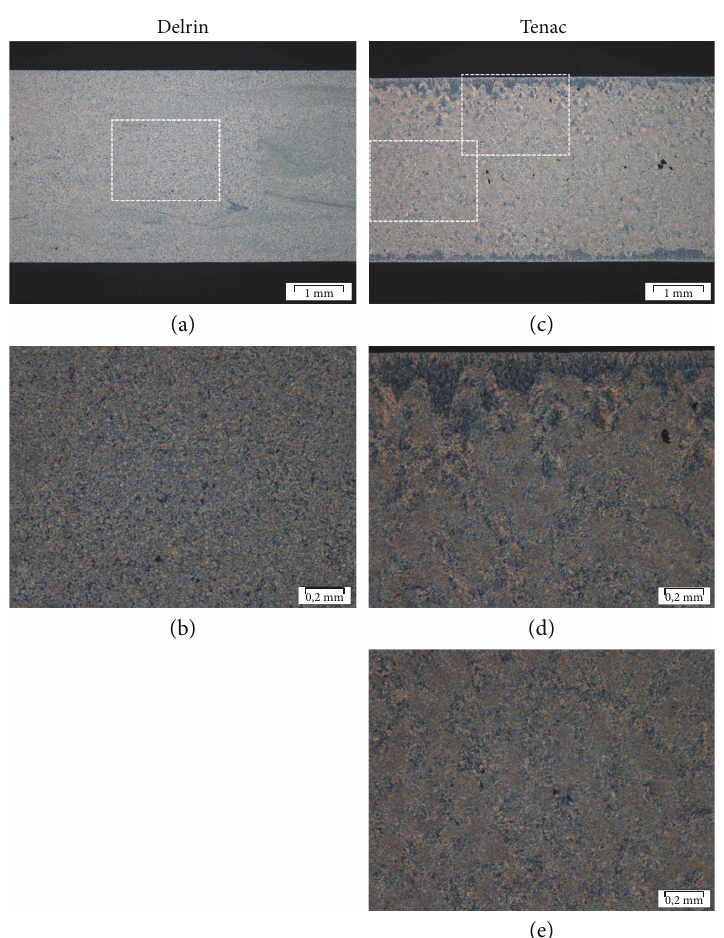
Figure 7: PLM images of the cross section of compression-molded plates. Overview and details for Delrin (a, b) and Tenac (c –